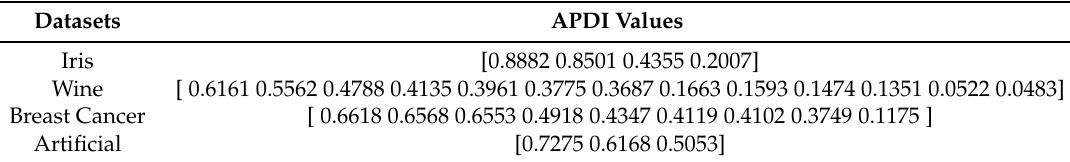
Table 6. Corresponding APDI in the same order.